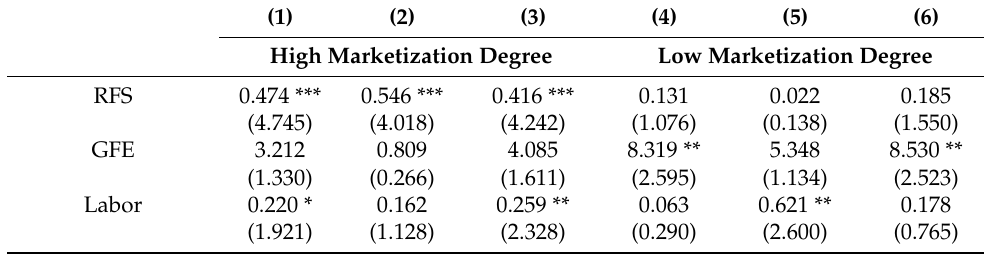
Table 5. Financial Scale, Degree of Marketization, and Agricultural Technology